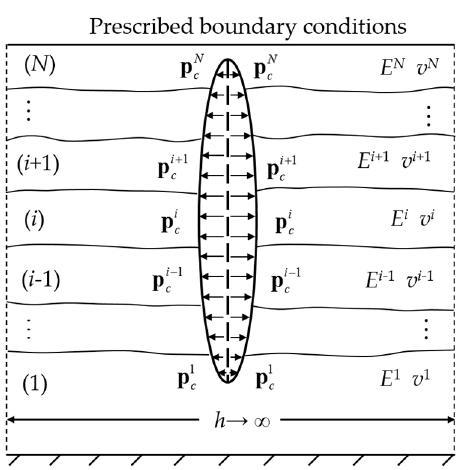
Figure 1. Schematic view of the crack problem [37].